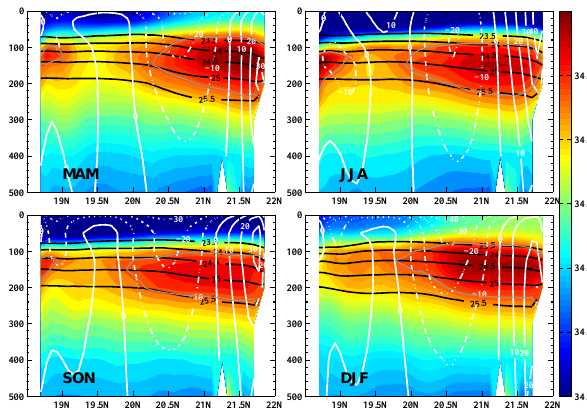
Figure 8. Seasonal salinity (color shading; PSU) and zonal velocity (white contours; cms − 1 ) along the Luzon Strait (120.8 ◦ E). Black lines represent the potential density. Grey contours indicate 34.68 PSU salinity. Positive (negative) values represent eastward (west- ward) currents. The contour interval of zonal velocity is 10cms − 1 .